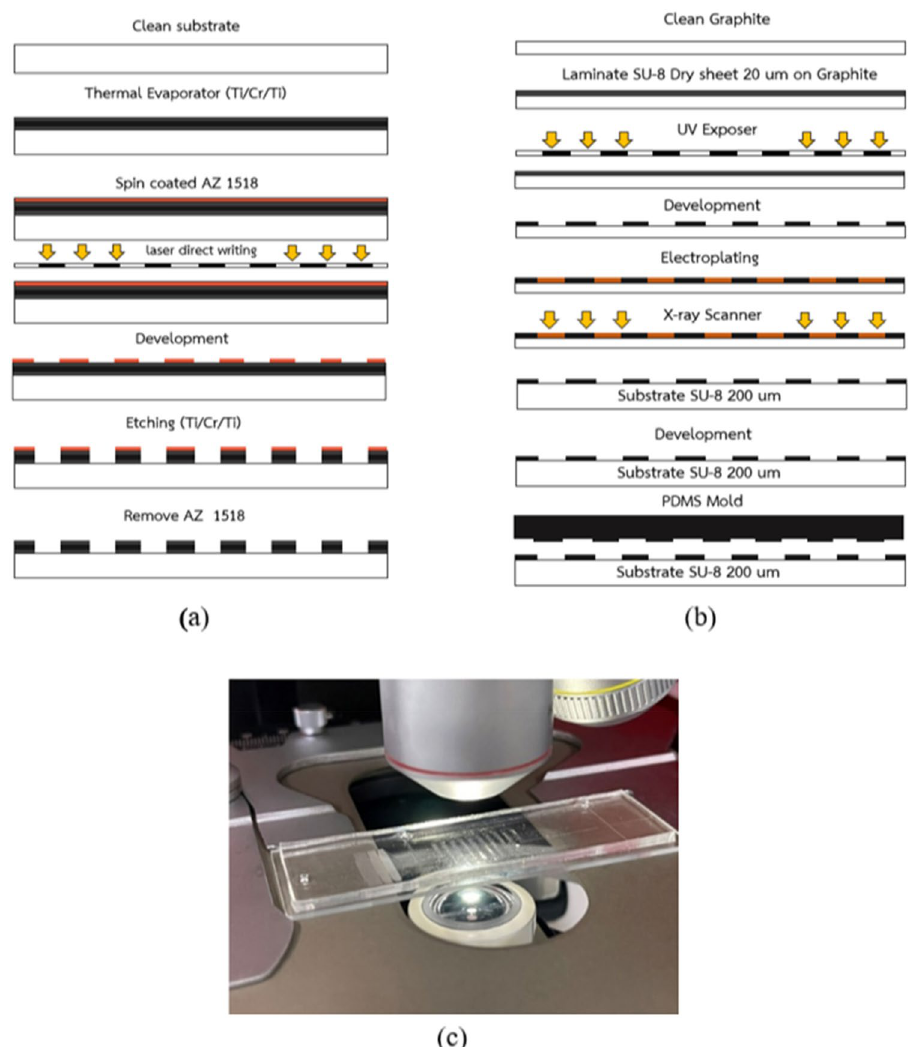
Figure 4. The fabrication process for microfluidic chips used in sorting and detecting somatic cells. ( a ) A Cr mask is fabricated using laser direct writing lithography. ( b ) An X-ray mask is created on a graphite substrate and then exposed through X-ray lithography on a 200 µm thick SU-8 photoresist. ( c ) The microchannel pattern is applied to the replicated PDMS to create the microfluidic